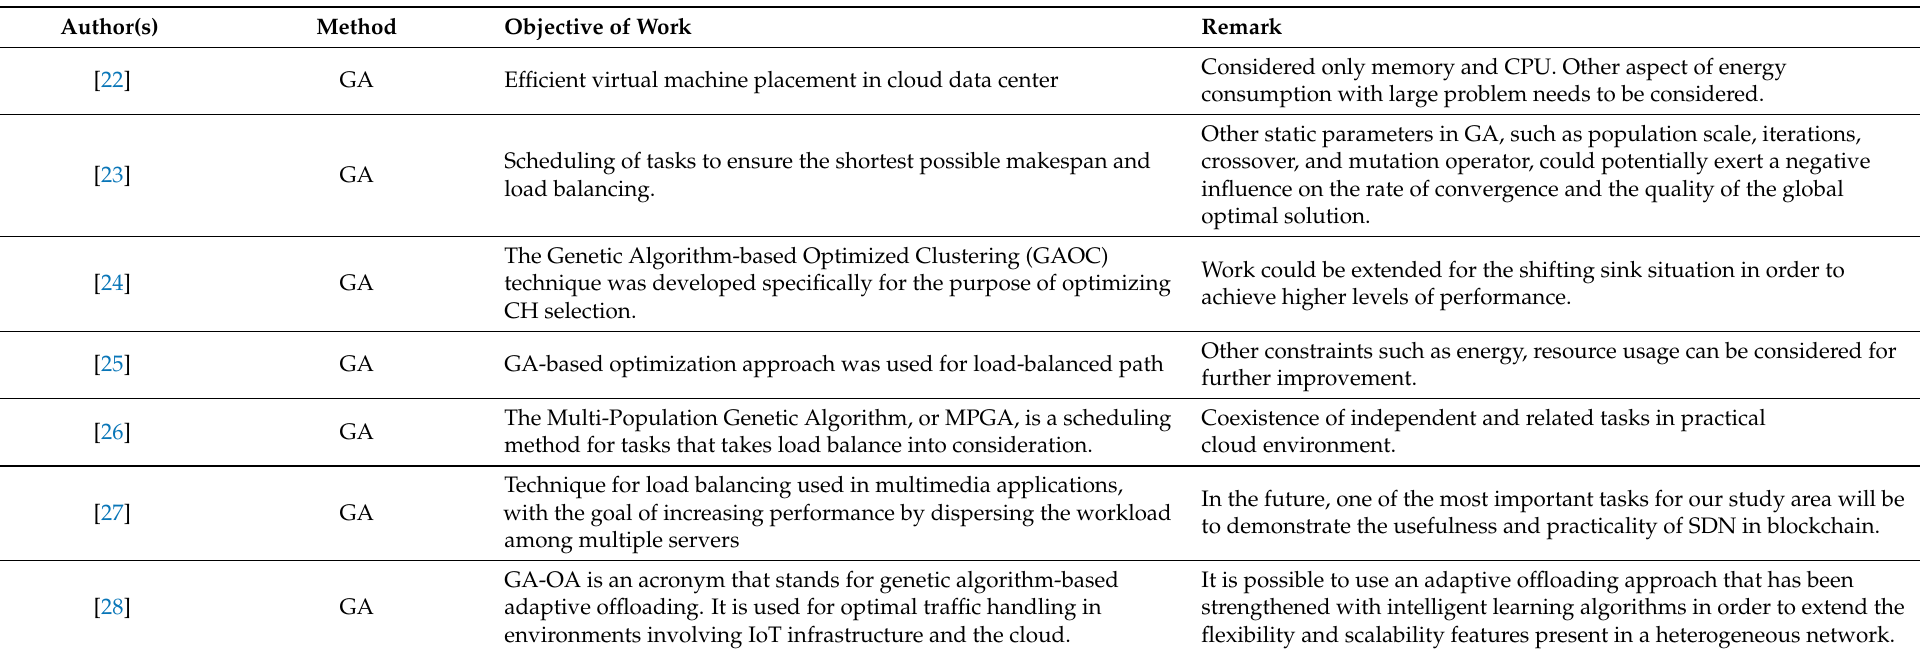
Table 1. Review of different Meta-heuristic Load-Balancing Approaches Using